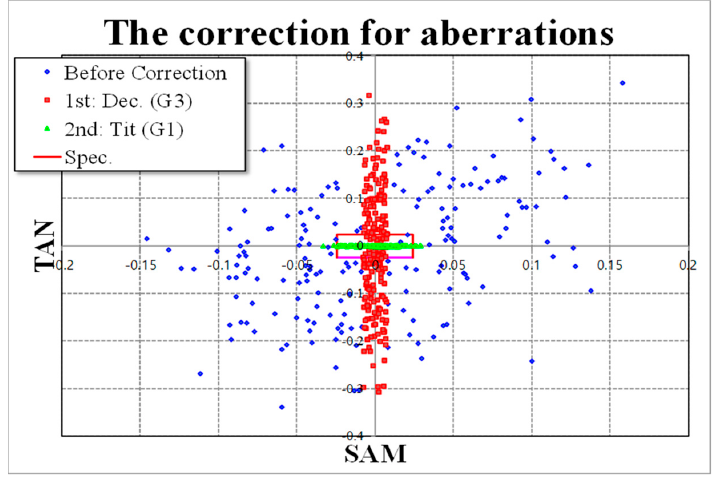
Figure 14. The correction for the designed optical system aberrations.